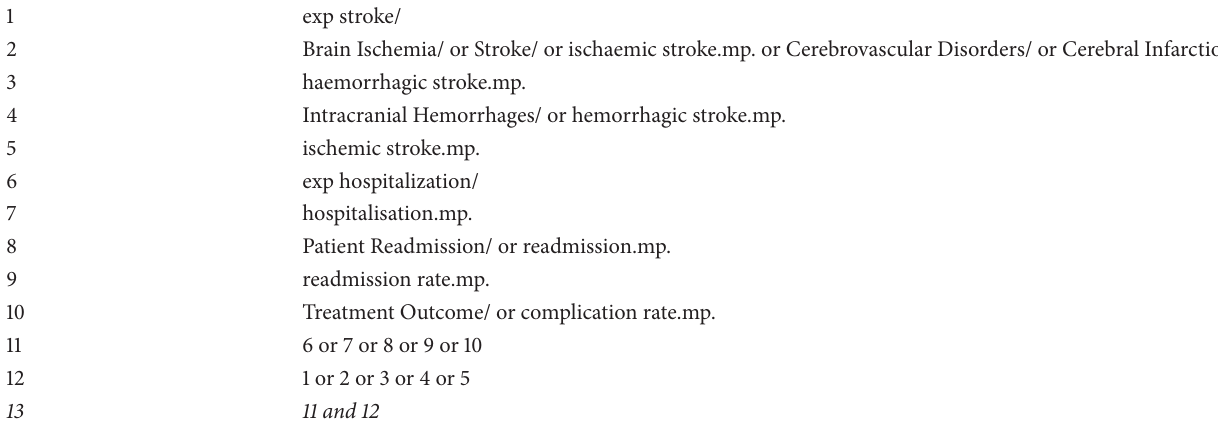
Table 1: MESH terms used for literature